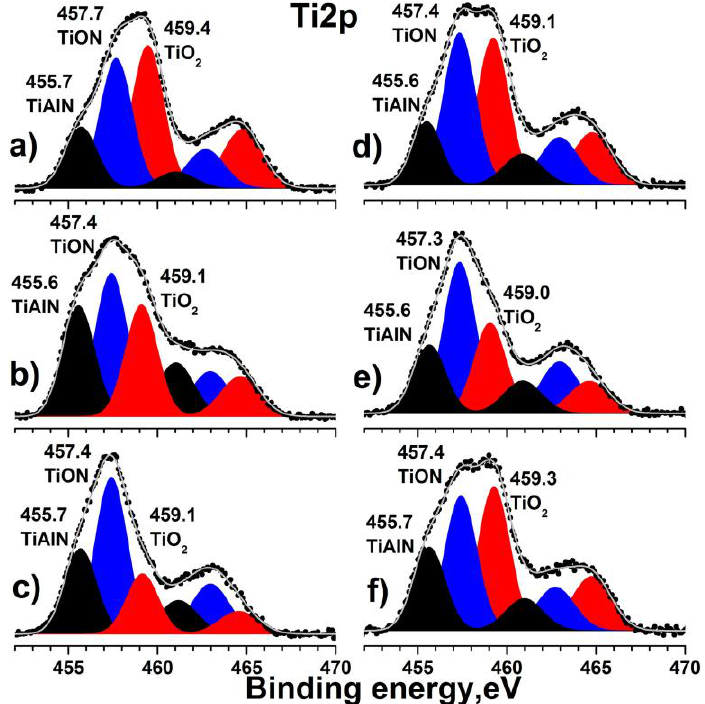
Figure 3. Ti2p XP-spectra obtained for Ti-Al-N films ( a ) 200 ◦ C, 20 sccm; ( b ) 200 ◦ C, 40 sccm; ( c ) 200 ◦ C, 60 sccm; ( d ) 500 ◦ C, 20 sccm; ( e ) 500 ◦ C, 40 sccm and ( f ) 500 ◦ C, 60 sccm after Ar + ion